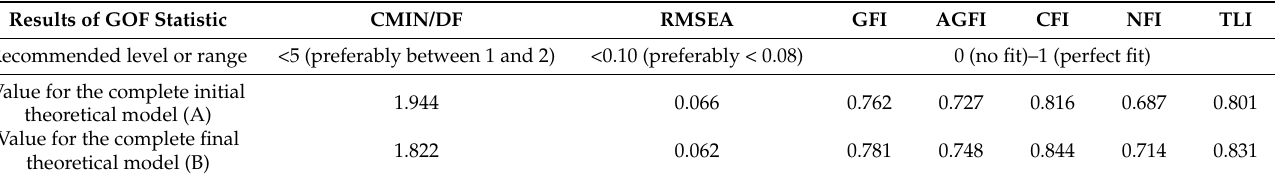
Table 2. Results of the